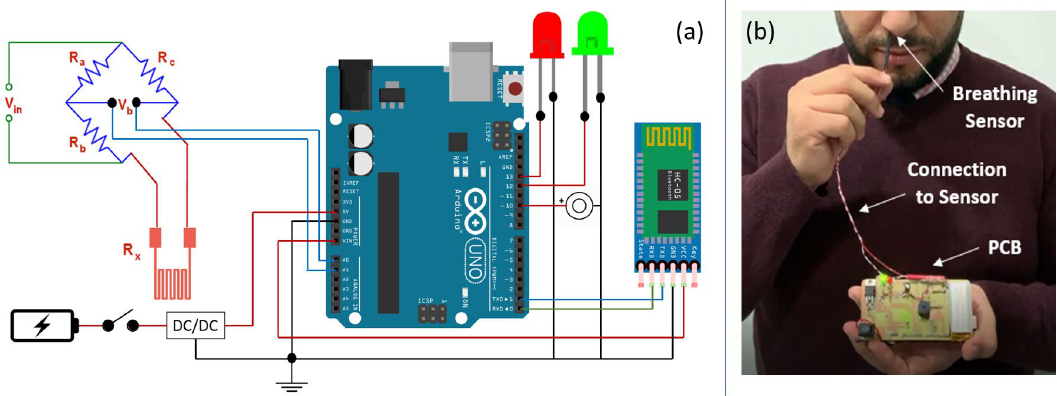
Figure 20. ( a ) System block diagram ( b ) Experimental